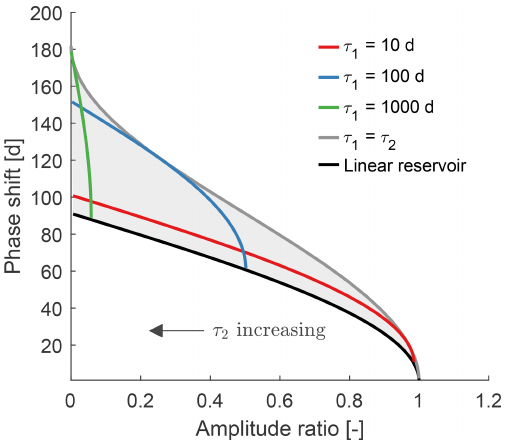
Figure 2. Amplitude ratio against phase shift for two linear reser- voirs in series. Each line corresponds to a fixed time constant for the first reservoir ( τ 1 ), while the time constant of the second reser- voir varies (1d ≤ τ 2 ≤ 10000d; it is increasing from right to left). The black line indicates a single linear reservoir (the lower bound- ary). The grey line indicates the upper boundary where τ 1 = τ 2 . The shaded area contains all possible combinations of amplitude ratio and phase shift for two linear reservoirs in